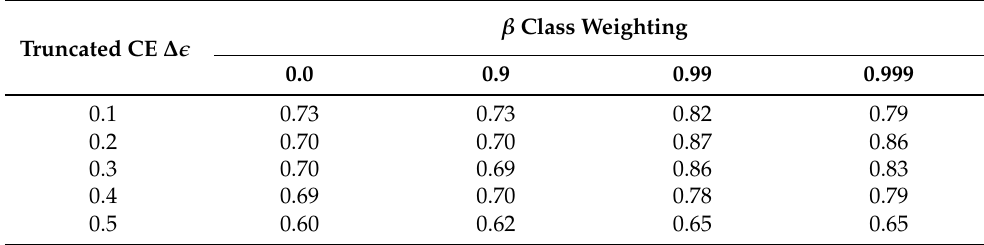
Table 4. Mean IoU of U-Net trained on Steveral with varying truncated cross-entropy loss